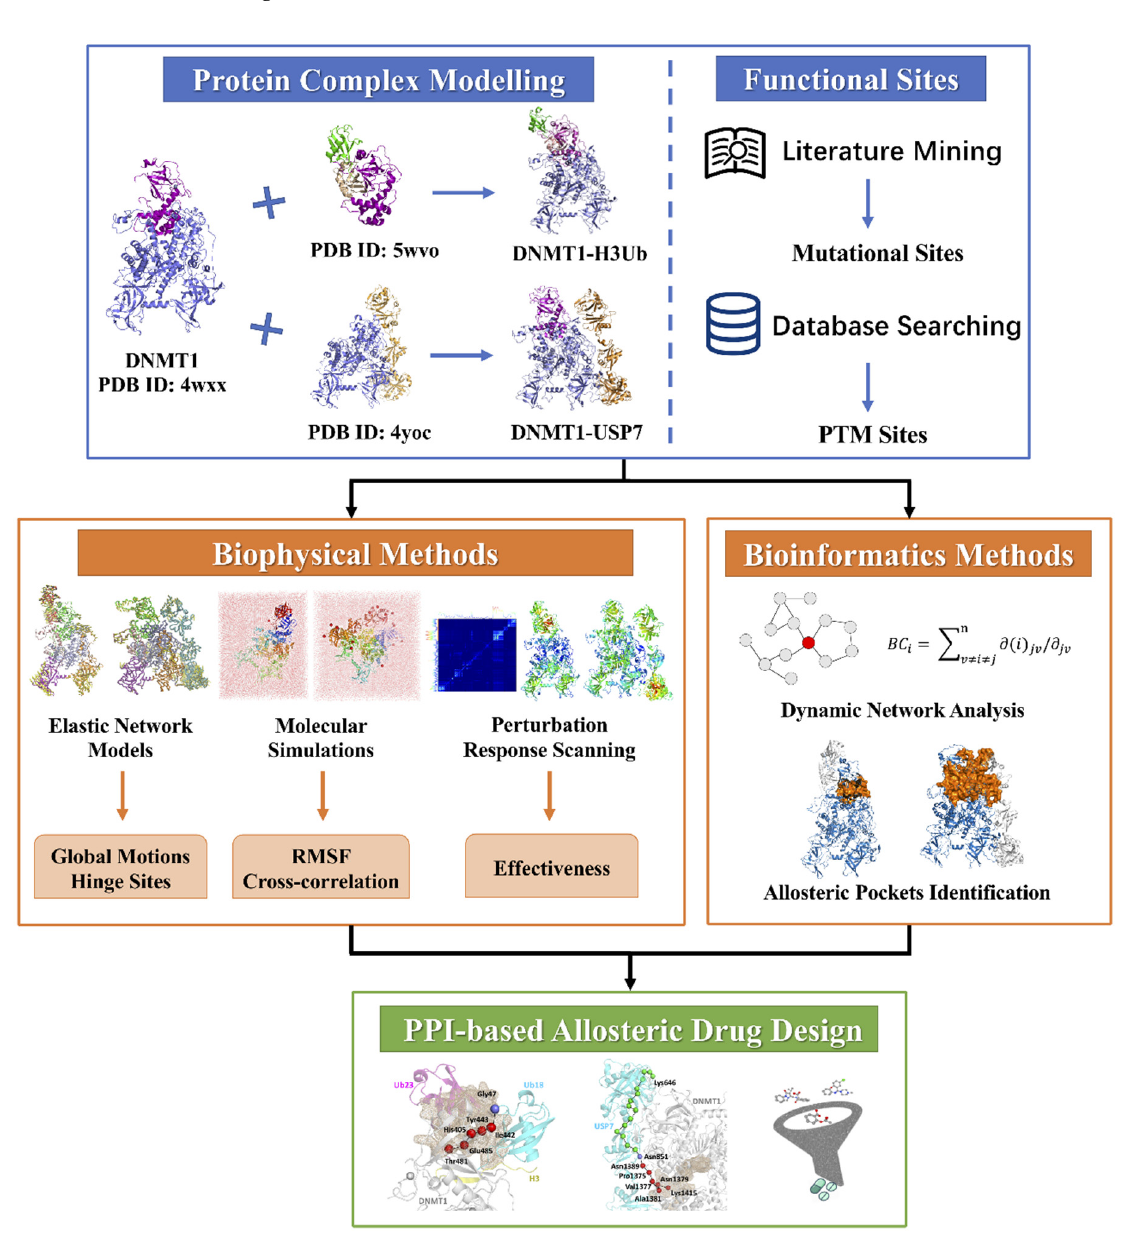
Figure 2 . The computational workflow of using elastic network models, molecular dynamics simulations, structural residue perturbation, network modeling, and pocket pathway analysis to study allosteric dynamics and drug design in DNMT1-H3Ub/USP7 complexes.